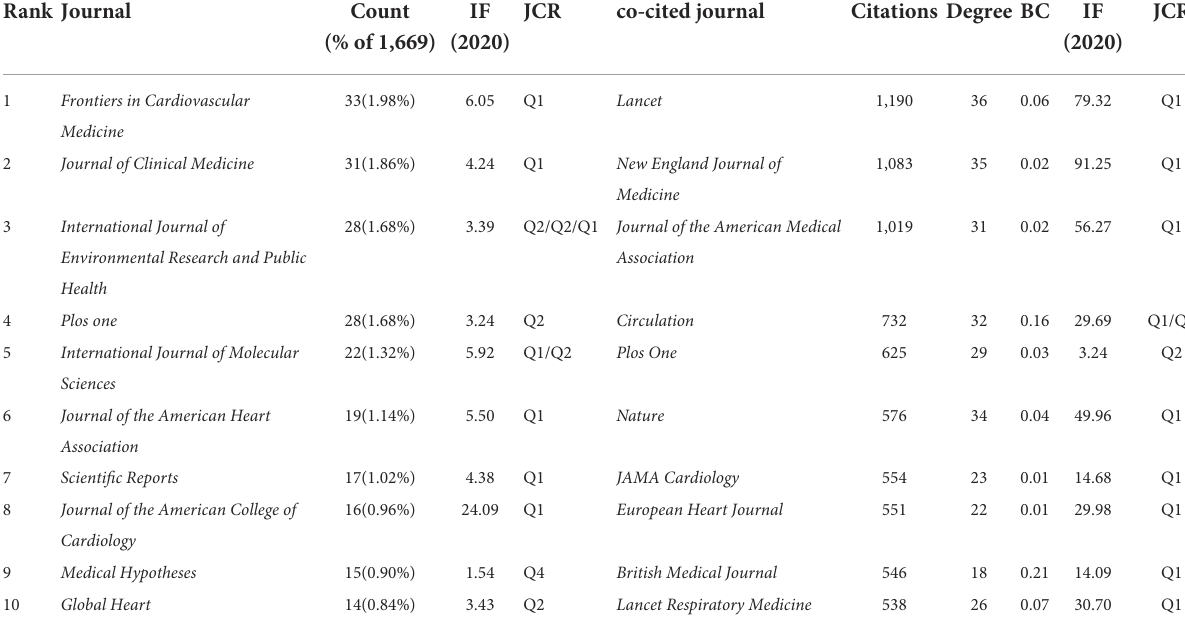
TABLE 4 Top 10 journals and co-cited journals in CVDs and COVID-19